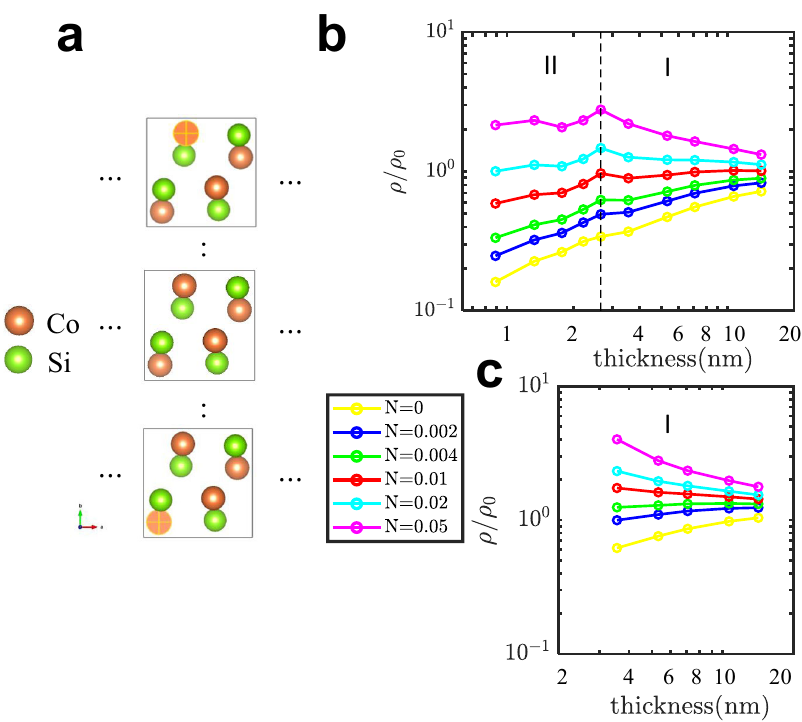
Fig. 3 Resistivity scaling in CoSi slabs with point defects. a Crystal structure of a CoSi slab. A yellow cross indicates the position of a surface vacancy point defect. b Longitudinal resistivity ρ as a function of the slab thickness, calculated from fi rst-principles electronic structure and Kubo ’ s formula, for different surface defect density N ( N ¼ 0 : 01 is equivalent to areal density (cid:2) 5 ´ 10 12 cm (cid:5) 2 ). In region I , well-differentiated surface and bulk states coexist at the Fermi level. In region II , only remnants of the surface states are present at the Fermi level. The resistivity in the in fi nite thickness limit is denoted as ρ 0 . c Longitudinal resistivity ρ as a function of the slab thickness in region I , calculated from a combined analytical and fi rst-principles approach (see Supplementary Discussion), for different surface defect density N